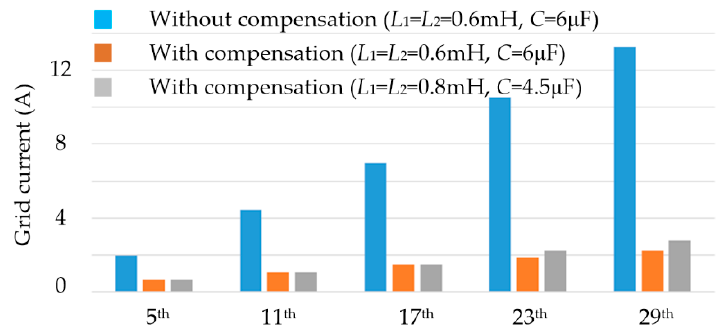
Figure 12. FFT results of grid current.